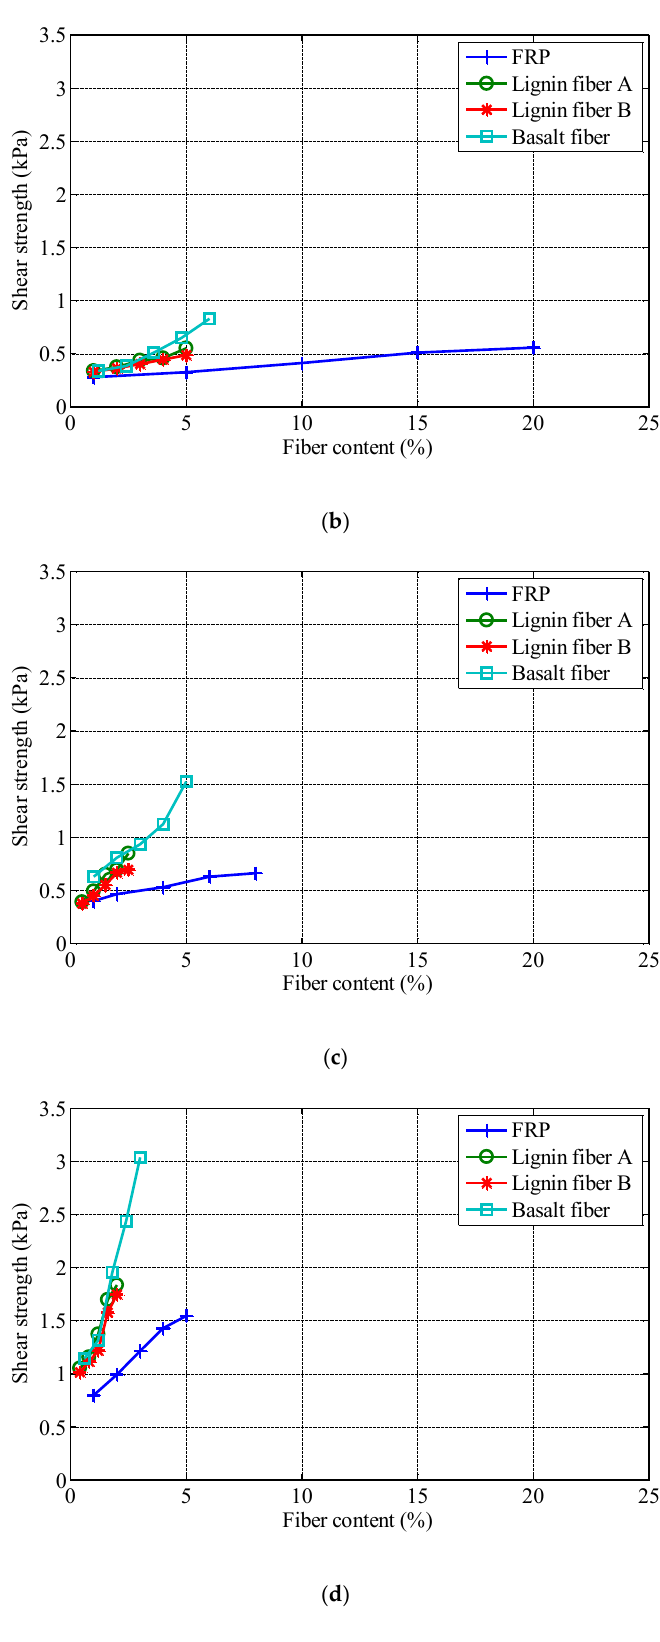
Figure 4. Shear strength of fiber-reinforced asphalt with various fiber contents: ( a ) asphalt No. 90; ( b ) asphalt No. 70; ( c ) styrene-butadiene-styrene (SBS) modified asphalt; ( d ) asphalt